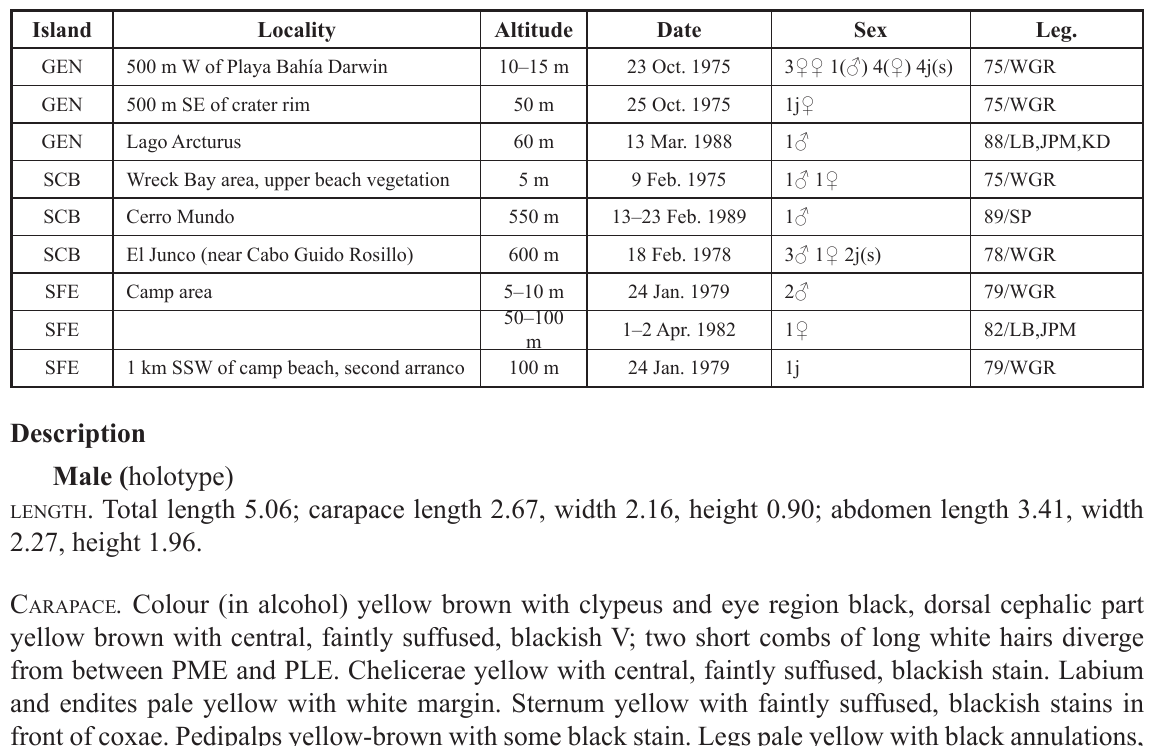
Table 2. Other material examined of Eustala orientalis sp. nov. abbreviations: GeN: Genovesa, SCB: San Cristóbal, SFE: Santa Fé; ♂: male, (♂): subadult male,♀: female, (♀): subadult female, j(s):